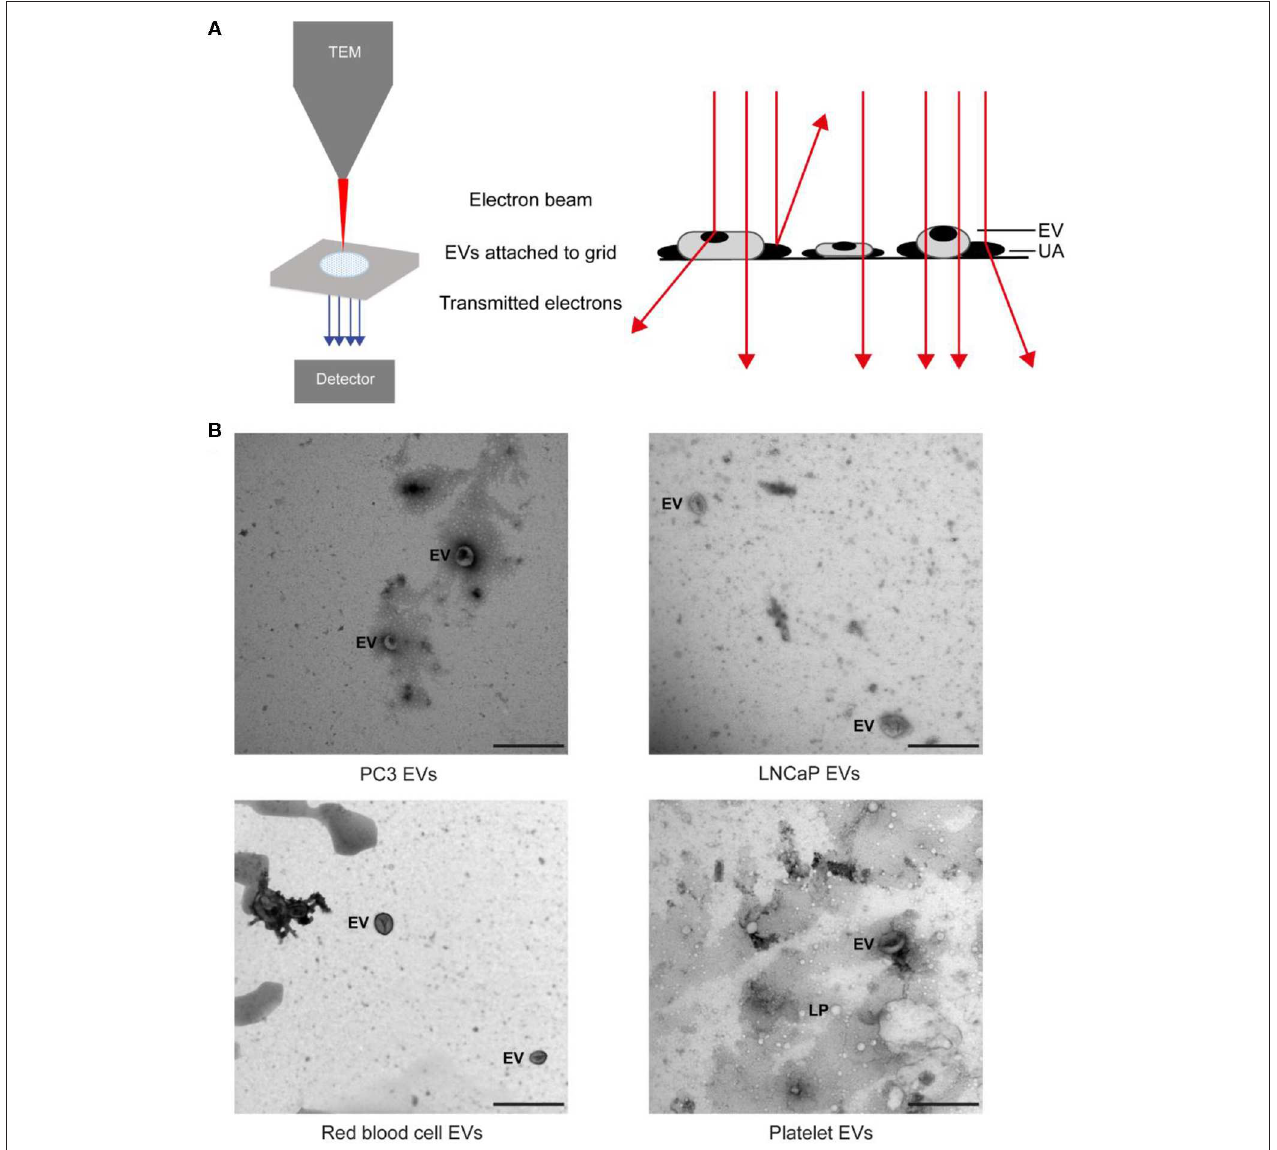
FIGURE 3 | Transmission electron microscopy (TEM) of extracellular vesicle (EV) samples. (A) Schematic representation of TEM imaging for EV samples. The sample on a grid is exposed to an electron beam, and images are constructed based on the detected transmitted electrons. The uranyl acetate (UA) scatters electrons efficiently, which results in negative contrast. EVs and lipoproteins (LPs) have a low electron density and are seen as bright particles in a dark background (13). (B) TEM images of the EV samples from PC3 and LNCaP and of red blood cells and platelets after size exclusion chromatography. The scale bar corresponds to 500nm